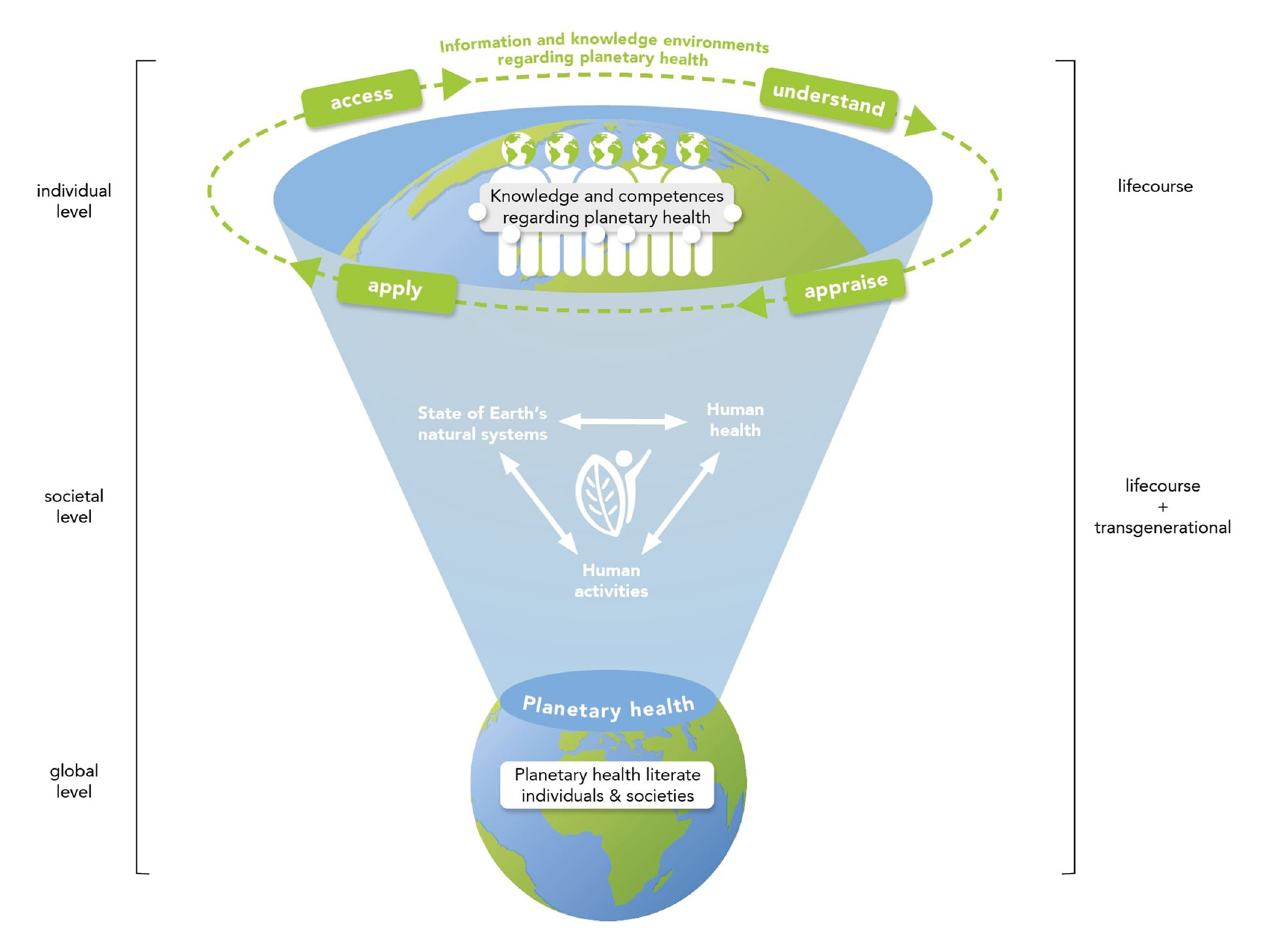
FIGURE1 A conceptual model of planetary health literacy. Zooming into the core of the model shows the relevance of knowledge and competences regarding planetary health, i.e., regarding the interconnectedness of human health and wellbeing with the state of the natural systems, at the individual level. Zooming into the individual level—as if looking through a magnifying glass—allows highlighting the knowledge and competencies that enable individuals to access, understand, appraise and apply information and knowledge environments regarding planetary health. Zooming out of the core of the model allows a more holistic view on the planetary level and shows planetary health literate individuals and societies as the desired outcome of education for planetary